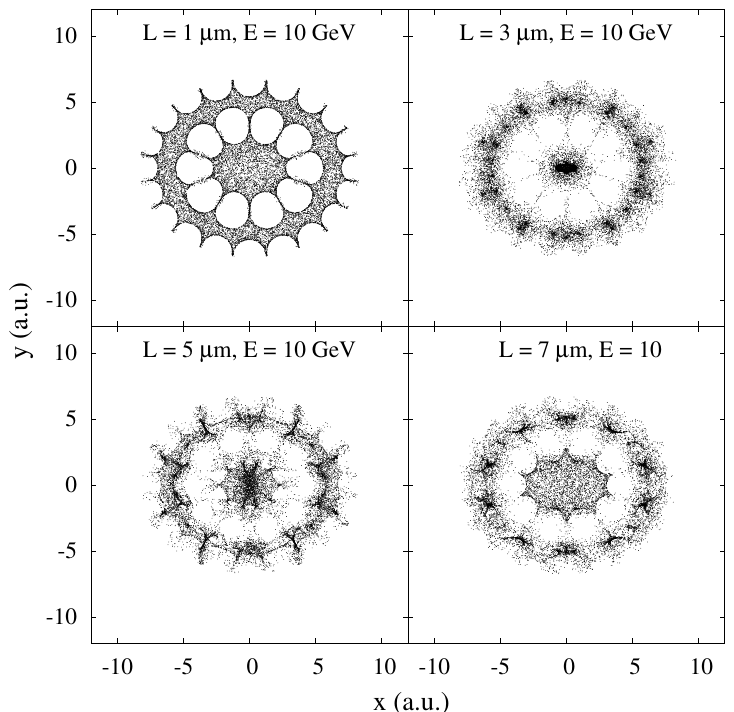
Figure 9. The spatial distributions of protons channeled in the radially deformed DWNTs(10, 0)@(5, 0) for different nanotube lengths: (left top) L = 1 µ m; (right top) L = 3 µ m; (left down) L = 5 µ m; (right down) L = 7 µ m, respectively. The radial strain is η = 0.1 and the proton energy is E = 1